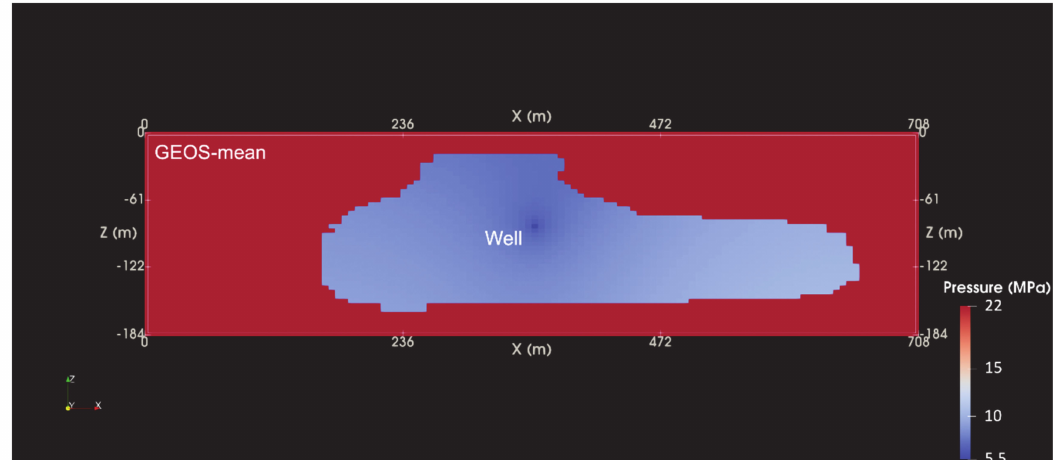
Figure 10. Pressure in the 3rd hydraulic fracture at 1000 days. The aperture of the fracture is homogeneous ( GEOS-mean) . Figure 11 illustrates the cumulative oil and gas production, as simulated by TOUGH+OGB, for the three fracture simulation cases GEOS-full , GEOS-mean and Rectan- gular . The values shown are multiplied by the number of stimulation stages to estimate overall production from the entire 4SM well. The use of a homogeneous ( GEOS-mean ) aperture results in a reduced estimate of cumulative oil production compared to the case with a heterogeneous aperture distribution (Figure 11a), both at early and later times, which is likely due to the limiting of the extent of the highest-permeability fracture pathways by the regions of constricted aperture (and thus lower conductivity). Simulated gas pro- duction (Figure 11b) shows relatively low values during the first 400 to 500 days followed by enhanced production for the remaining time period. The late gas production increase is likely due to the localized increase in pressure gradients within the fracture and the near-fracture zone in the matrix, which tends to enhance exsolution of gas from the oil.